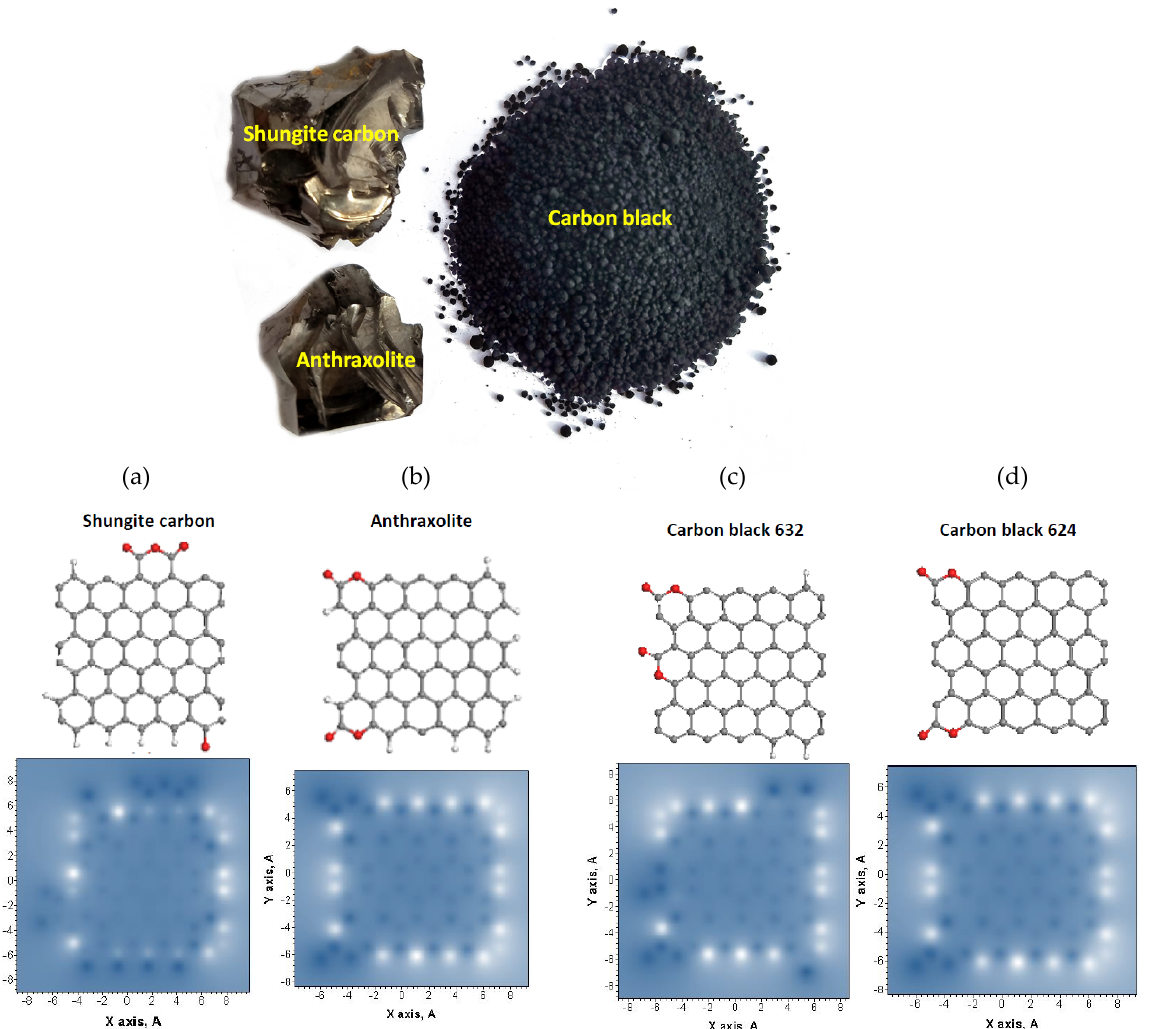
Figure 9. Appearance of natural amorphous carbon (top) and equilibrium structures of molecular BSU models (middle): ( a ) graphene oxihydrides C 68 O 4 H 6 attributed to “C=O” shungite carbon, ( b ) C 64 O 4 H 10 of “O=C-O-C’ antraxolite, ( c ) and ( d ) C 64 O 4 H 3 ( c ) and C 64 O 4 ( d ) of “C-O-C” carbon blacks CB632 and CB624, respectively. (bottom) N DA distribution over atoms Figure 9. of BSU model molecules (see text). UHF